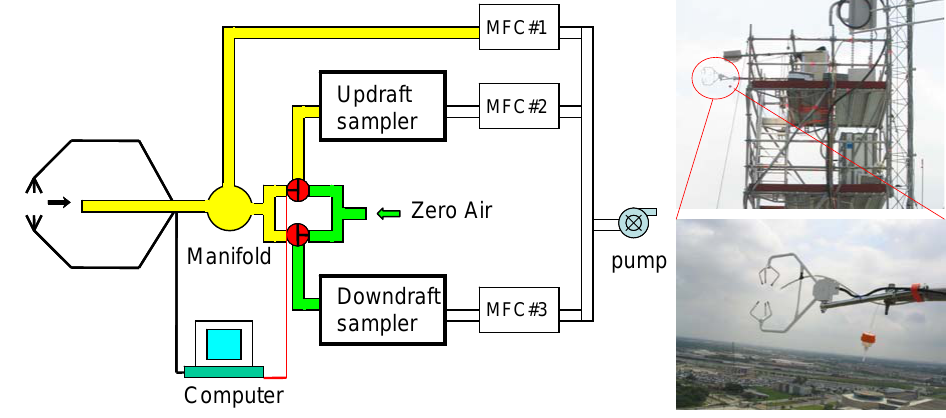
Figure 1. Left: schematic of a Relaxed Eddy Accumulation (REA) system for HONO flux measurement. Right: pictures showing the actual instrumentation during a field study. Both the REA system and the HONO analyzer were installed on a tower.